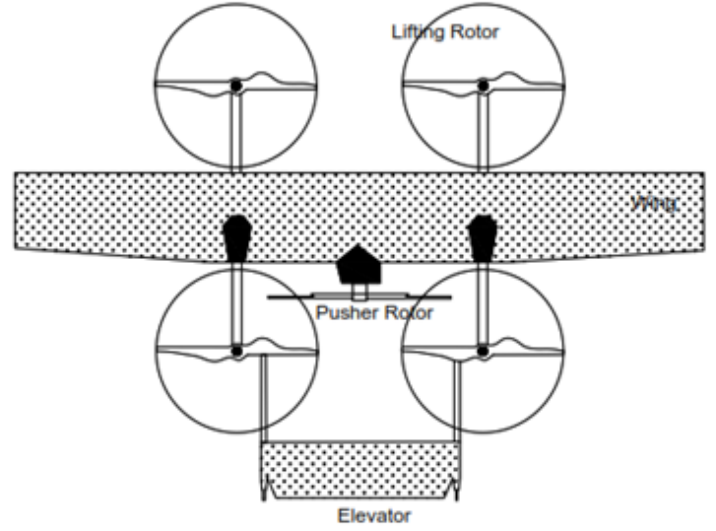
Figure 5. Hybrid VTOL.